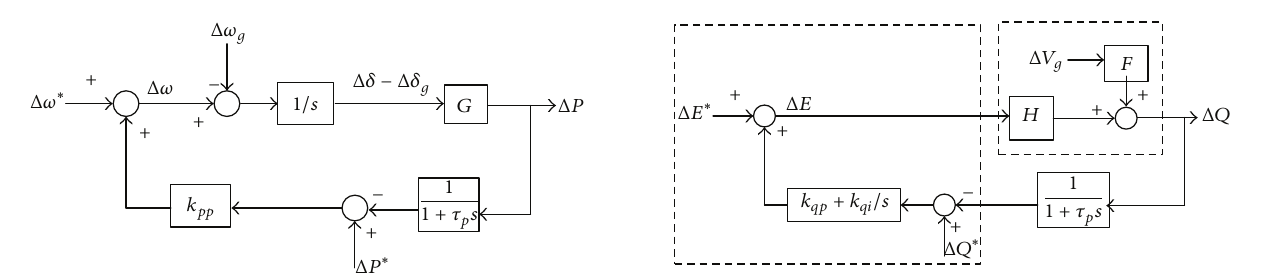
Figure3:Smallsignalmodeloftheconventional 𝑃 - 𝜔 droopcontrol. where 𝐺 = (𝐸 𝑜 ⋅𝑉 𝑔𝑜 ⋅ cos (𝛿 𝑜 −𝛿 𝑔𝑜 ))/𝑋 , 𝑑(Δ𝛿(𝑠)−Δ𝛿 𝑔 (𝑠))/𝑑𝑡 = (𝑠) . Δ𝜔(𝑠) − Δ𝜔 𝑔